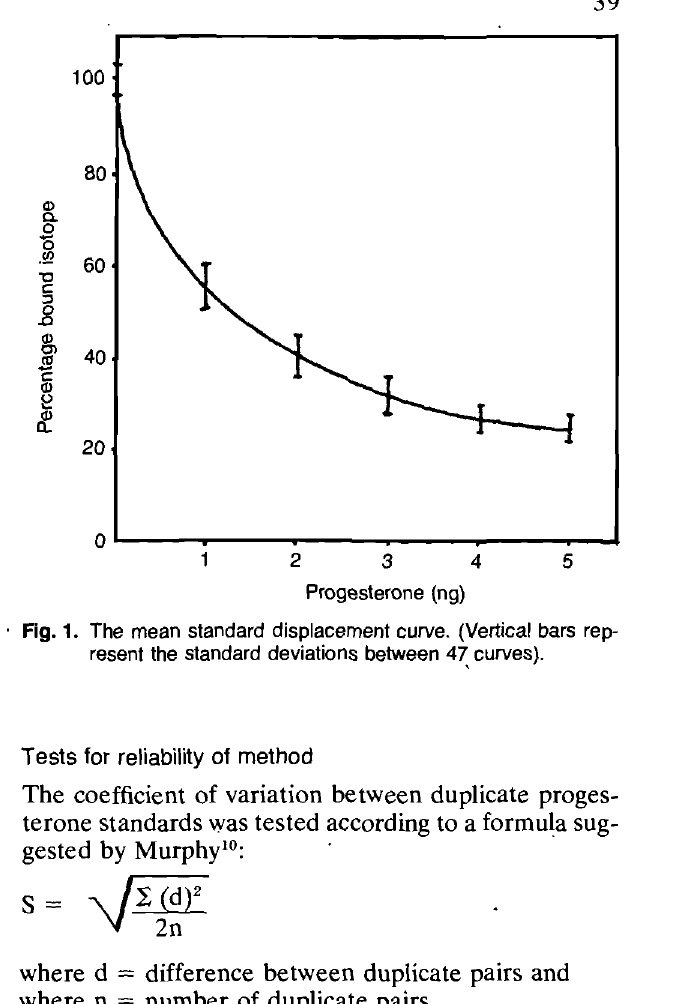
Tests for reliability of method